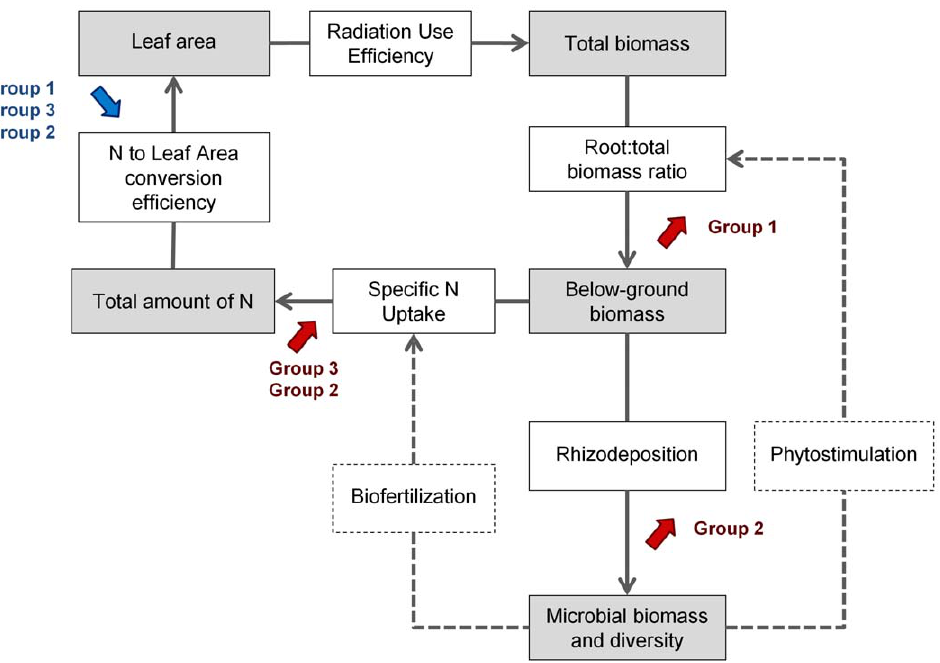
Figure 4. Contrasted adaptive responses of different Medicagotruncatula genotypes to nitrogen availability. Contrasted adaptive responses of different Medicago truncatula groups of genotypes to nitrogen availability was assessed using a conceptual framework of plant functioning [15] extended to plant-microbe interactions. Group 1 includes DZA315-16 and DZA315-26; Group 2 includes F83005-5 and SA028064; Group 3 includes Jemalong-A17, Jemalong-J6. State integrative variables are in grey boxes, efficiency variables are in white boxes and non-measured putative effects are in dotted boxes. The red and blue arrows represent respectively a significant increase and decrease, from low to high N availability.